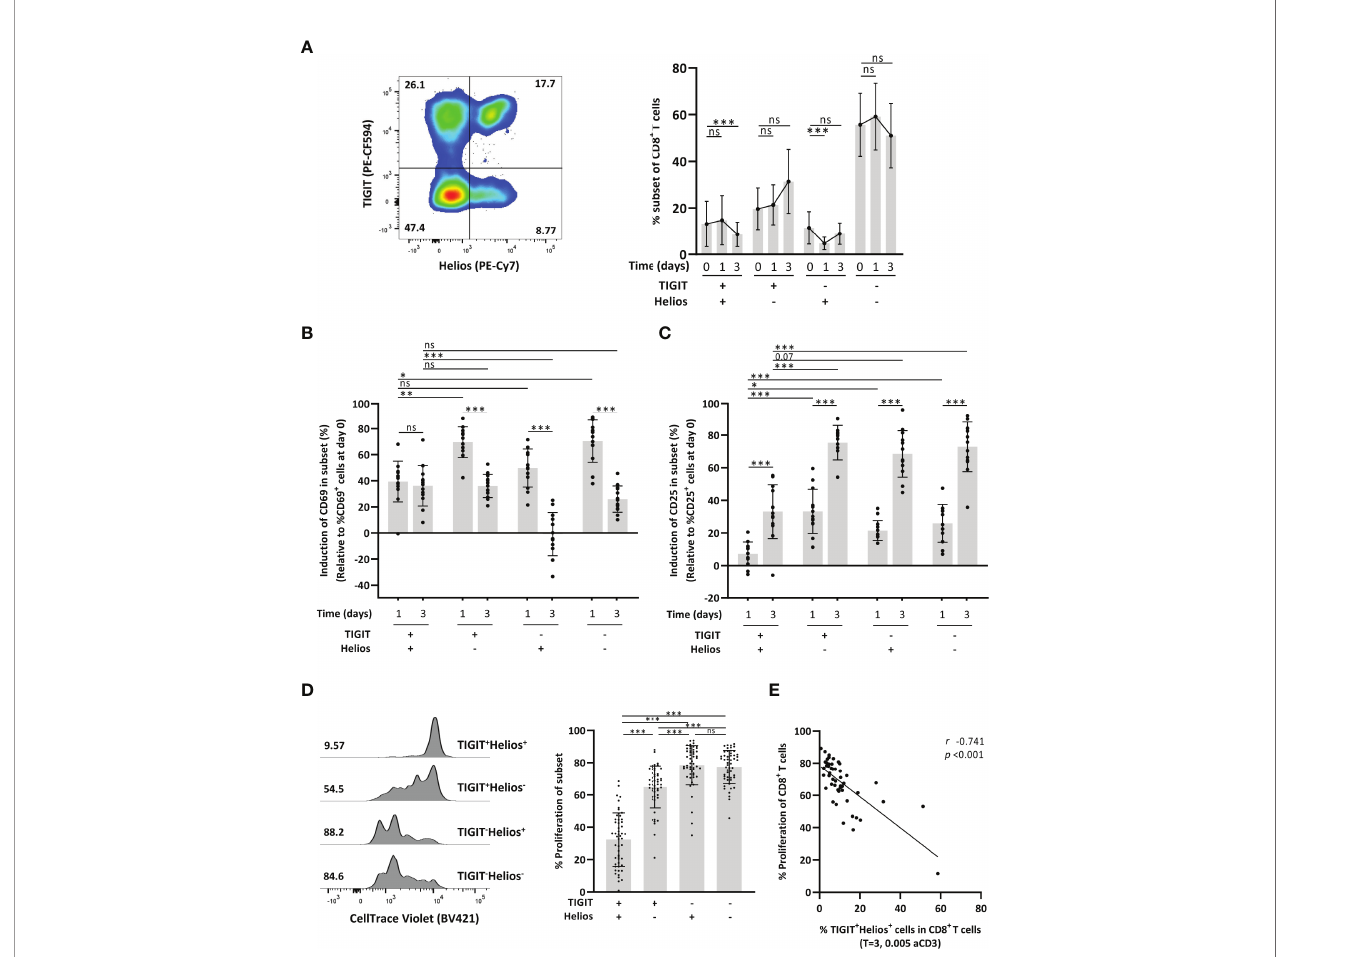
FIGURE 1 | Co-expression of TIGIT and Helios de fi nes functionally senescent CD8 + T cells. (A) Representative fl ow-cytometry plot with expression of TIGIT and Helios by CD8 + T cells and the frequency of TIGIT/Helios cell subsets among CD8 + T cells over time after stimulation of unsorted whole PBMC samples with anti- CD3 (day zero, one, and three) are shown. Induction of T-cell activation was assessed by measuring the frequency of (B) CD69 + cells and (C) CD25 + cells over time within the indicated TIGIT/Helios cell subsets relative to the frequency of CD69 + and CD25 + cells determined at day zero (% CD69 + or CD25 + cells at indicated day minus their % at day 0) (n = 13). T-cell proliferation was assessed by dilution of CellTrace after three days of stimulation with anti-CD3. (D) Representative histogram shows the proliferation of the indicated TIGIT/Helios cell subsets by dilution of CellTrace (number indicates the frequency of proliferated cells of the subset). Bar graph shows the frequency of proliferated cells within each TIGIT/Helios cell subset (n = 50). (E) Relationship between the frequency of proliferated CD8 + T cells and the frequency of TIGIT + Helios + cells within the CD8 + T-cell population after three days of stimulation. All frequencies of proliferating cells were relative to their unstimulated control sample. Correlations ( r and p values) were assessed by Spearman test. Statistical signi fi cance of data presented in the bar graphs (means ± s.d.) was determined using Friedman test (with Dunn ’ s post-test). Wilcoxon test was used in panels (B, C) for the comparison between the time points within each subset. (* p < 0.05, ** p < 0.01, *** p < 0.001, ns, not signi fi